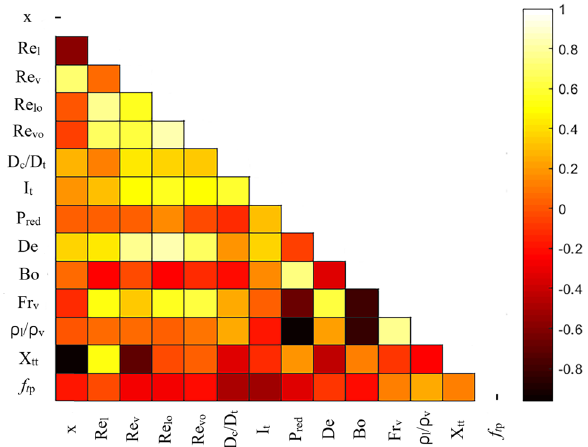
Figure 5. Heatmap of Spearman’s correlation coefficient between different